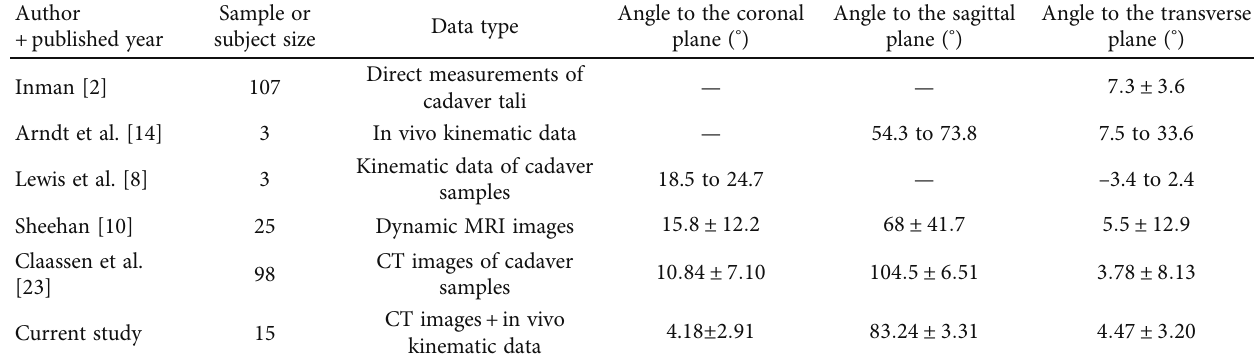
Table 1: A summary of the orientation of the rotational axis measured from previously published